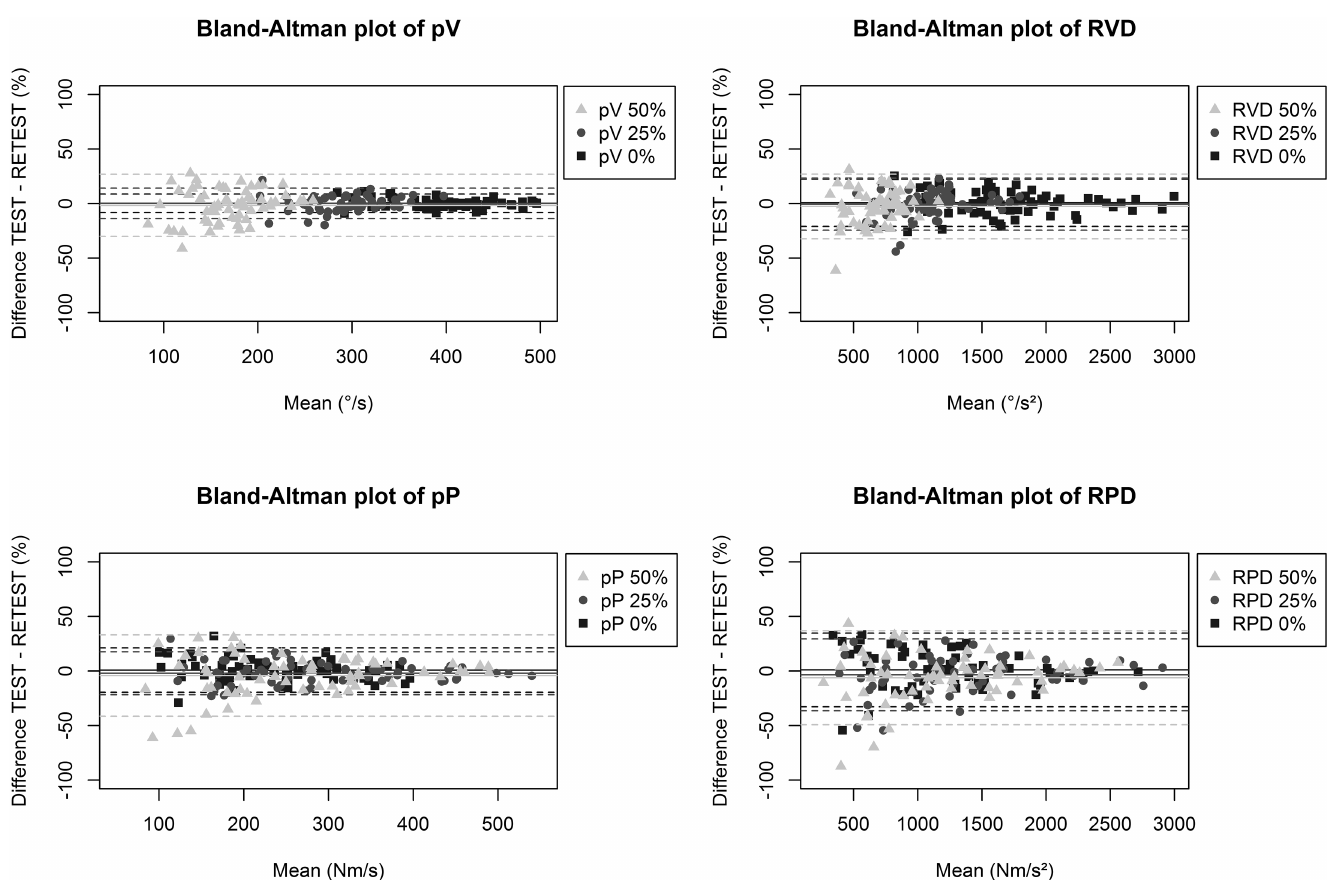
Fig 1. Bland-Altman plots. Bland-Altman plots of peak velocity (pV), rate of velocity development (RVD), peak power (pP) and rate of power development (RPD) illustrate absolute reliability of the isotonic knee extension tests at 0%, 25% and 50% of isometric maximum strength. Individual differences between test and retest values are plotted against their means. For all plots at all loads the mid solid line represents the mean difference, whereas the outer dashed lines represent the limits of agreement (LoA) in percentage.